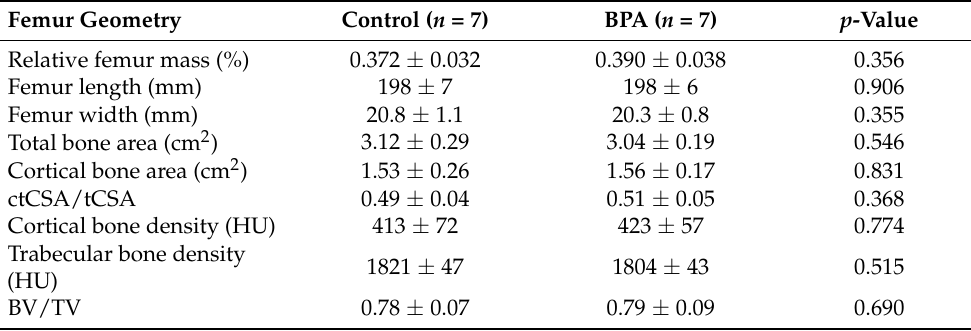
Table 3. Femur geometry (left femurs) and histomorphometry of EGP (right femurs) of rams in the BPA and control groups at the end of the study. The BPA group received 25 µ g BPA/kg bw/day for 64 days. Values are given as the mean ±